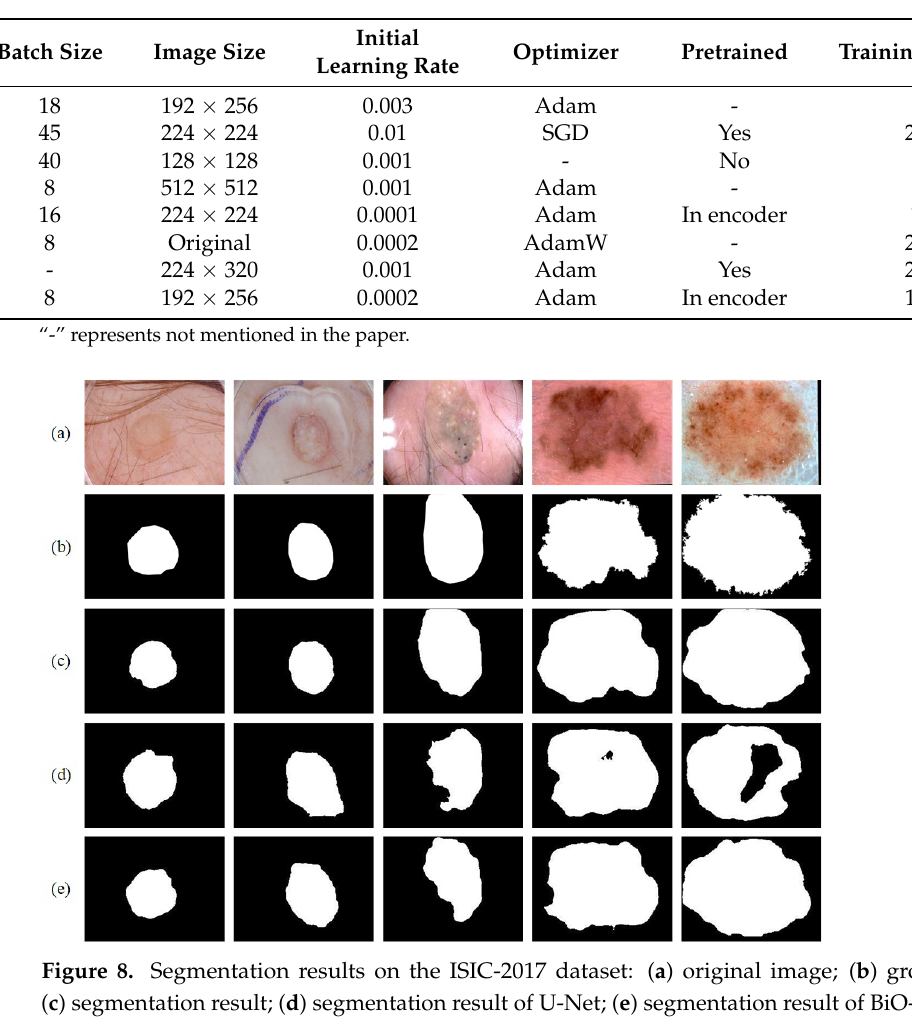
Table 5. Configurations of methods listed in Table 4.